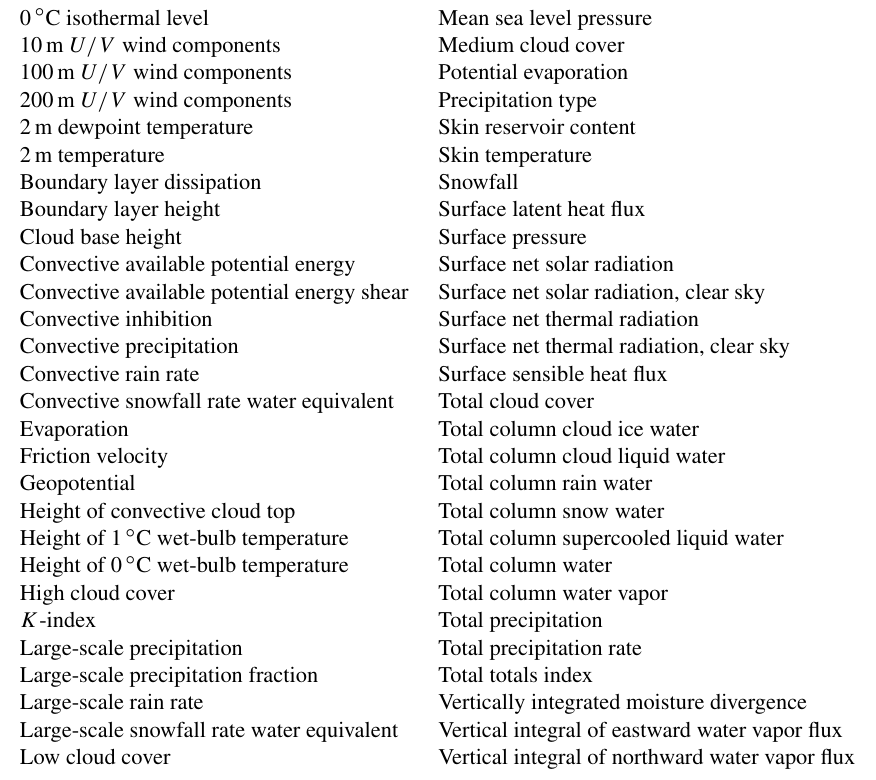
Table B5. Variables from the ECMWF model output adopted in this study.